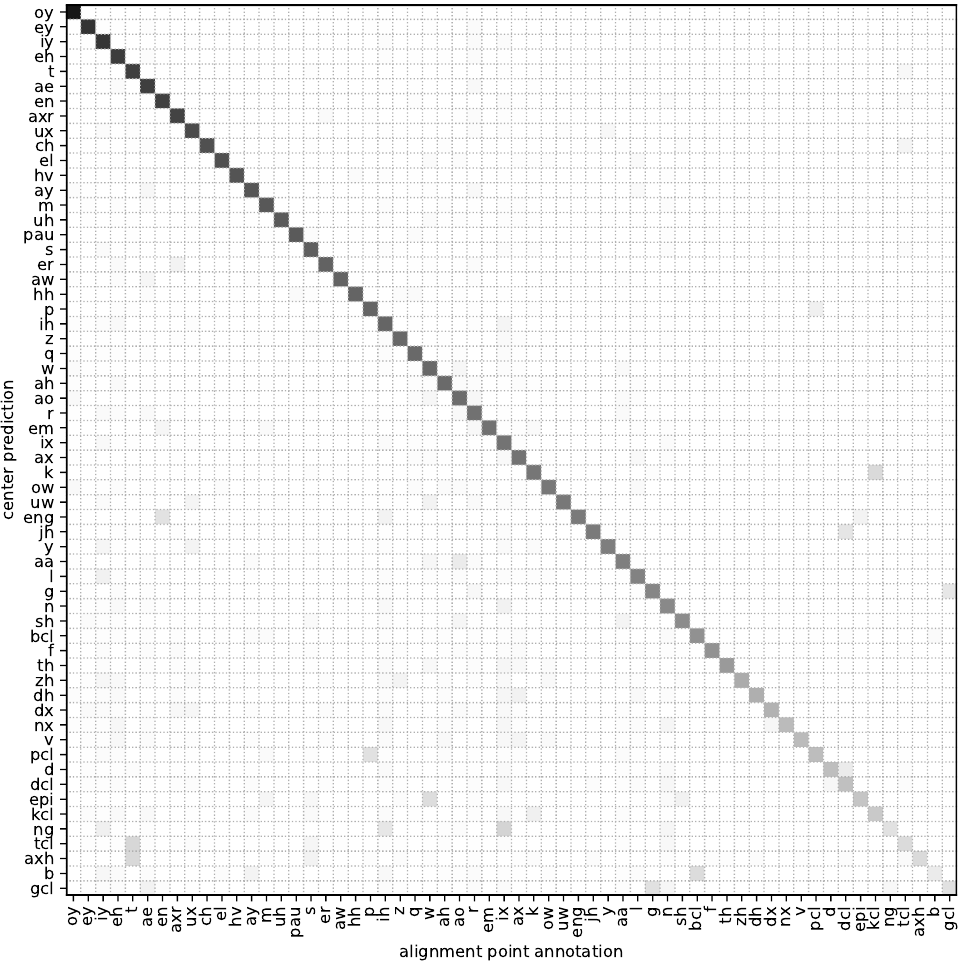
Figure 3. Alignment evaluation overview W2P_shallow. For each predicted class on the y -axis the relative frequency of the corresponding phoneme annotation on the x -axis after alignment is shown. Color scale [0, 1] from white to